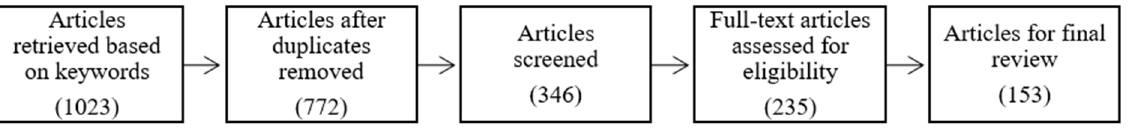
Figure 2. Article selection process. Source: Researchers’ own source.